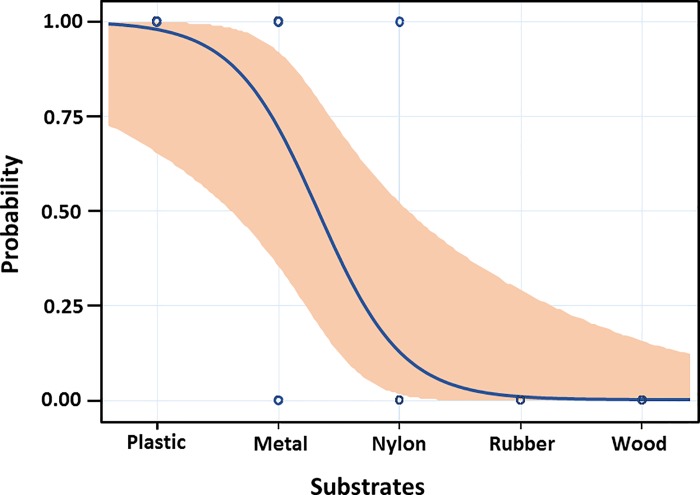
Probability plot for the ability of aqueous O3 of 4 ppm for 4 minutes exposure time to decrease the bacterial load with 5-log10 on plastic, metal, nylon, rubber, and wood materials.The curve shows the likely probability of 5-log10 bacterial reduction for each material, with the 95% confidence interval for the probability.